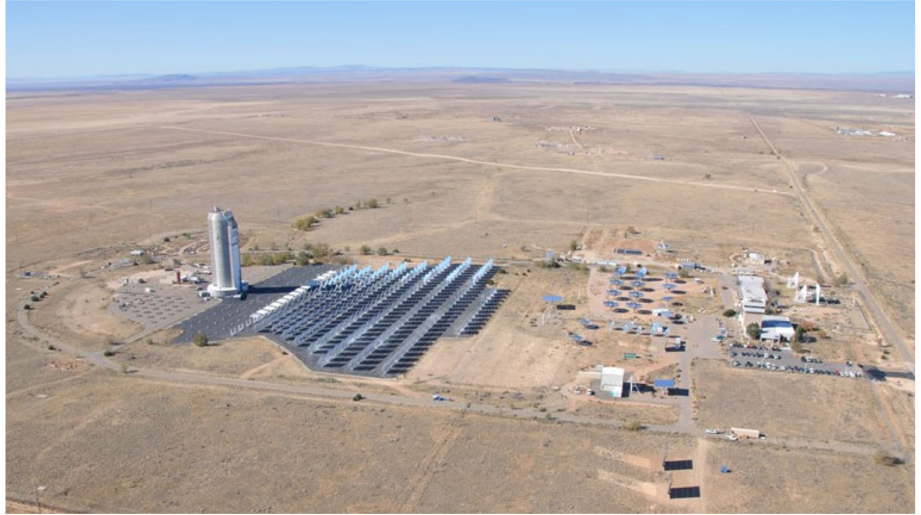
Figure 1. Sandia’s National Solar Thermal Test Facility (NSTTF) in Albuquerque, NM, USA (photo: C. Ho,